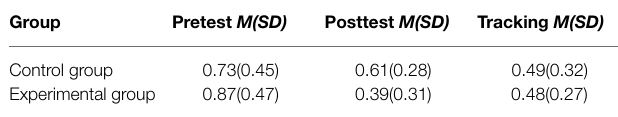
TABLE 2 | Mean IAT effect values (D) by